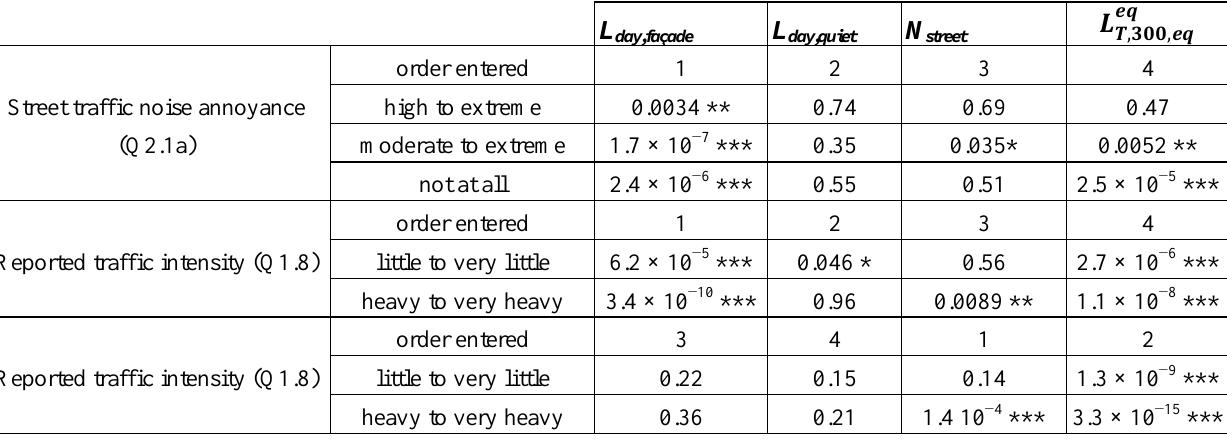
Reported traffic intensity (Q1.8)